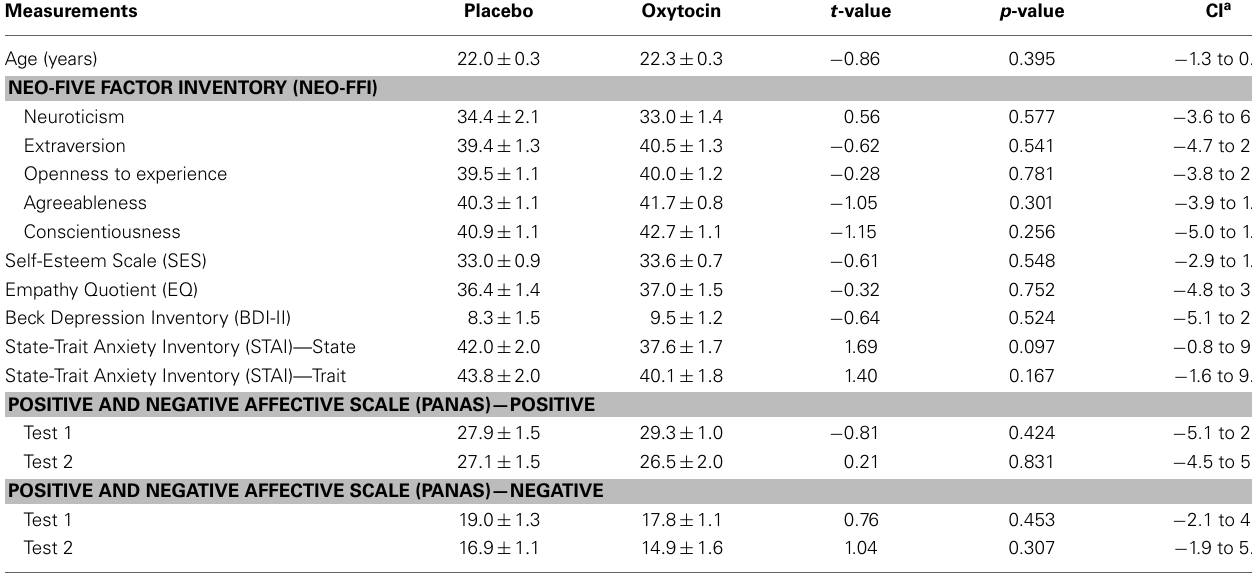
Table 1 | Ages and questionnaire scores for study subjects (mean ±